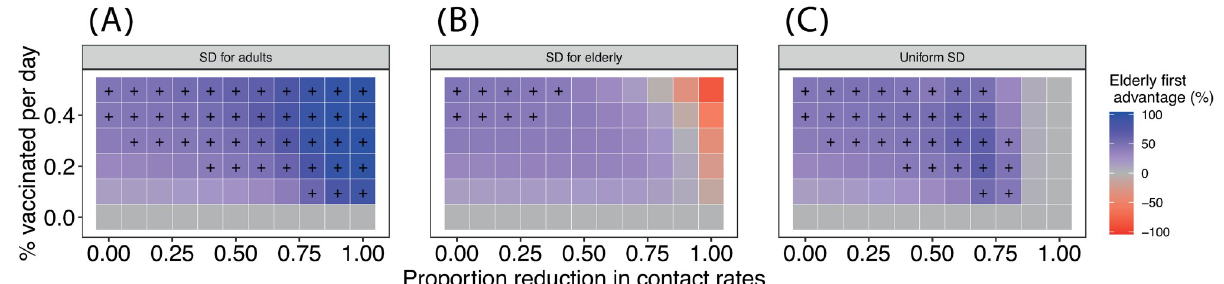
Fig 4. Systematic comparison between vaccination strategies in reducing hospitalizations. Each square in the heat maps depicts the percent difference in the number of hospitalizations between the two vaccination strategies ( D social distancing (x-axis), vaccine deployment rate ( κ , y-axis) and social distancing strategy (panels A-C). Color scale depicts the advantage of an elderly first strategy compared to an adults first strategy. Combinations higher than the median D underlying H a and H e for a 50% reduction in contacts can be found in S7